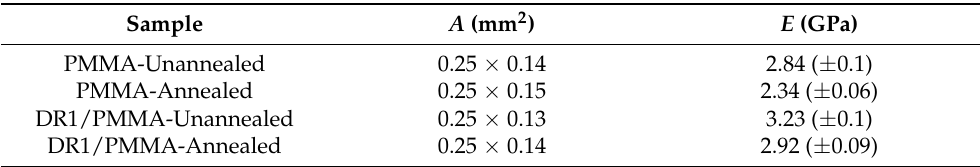
Table 1. Dimensions and Young’s modulus at room temperature of unannealed and annealed PMMA and DR1/PMMA